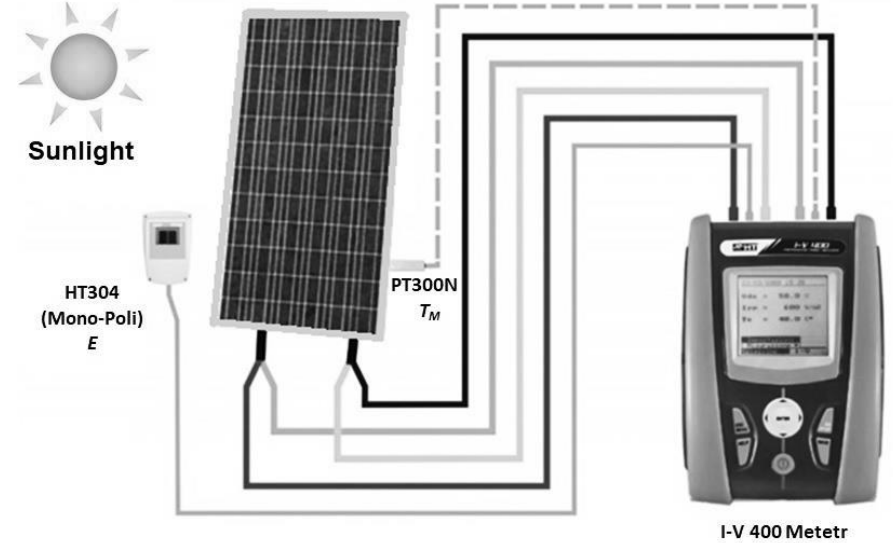
Energies 2019 , 12 , x FOR PEER REVIEW Figure 4. Method of measurement of I–V characteristics using the I–V 400 meter [22].